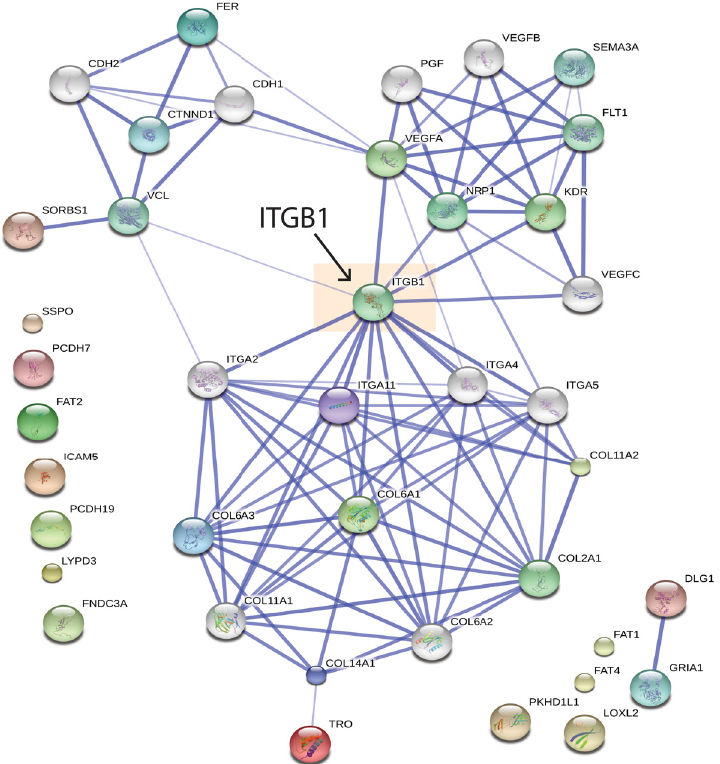
Fig 2. STRING analysis reveals functional interaction of cell migration and adhesion proteins depleted from the cell surface by A-769662 treatment. The list of 32 proteins with cell adhesion and migration GO annotation (Table 2) was subjected to STRING analysis to visualize known and predicted interactions [54]. Shown is a graphical representation of the output of this analysis. Highlighted is the predicted interaction of proteins identified as depleted from the cell surface fraction upon A-769662 treatment with β 1-integrin